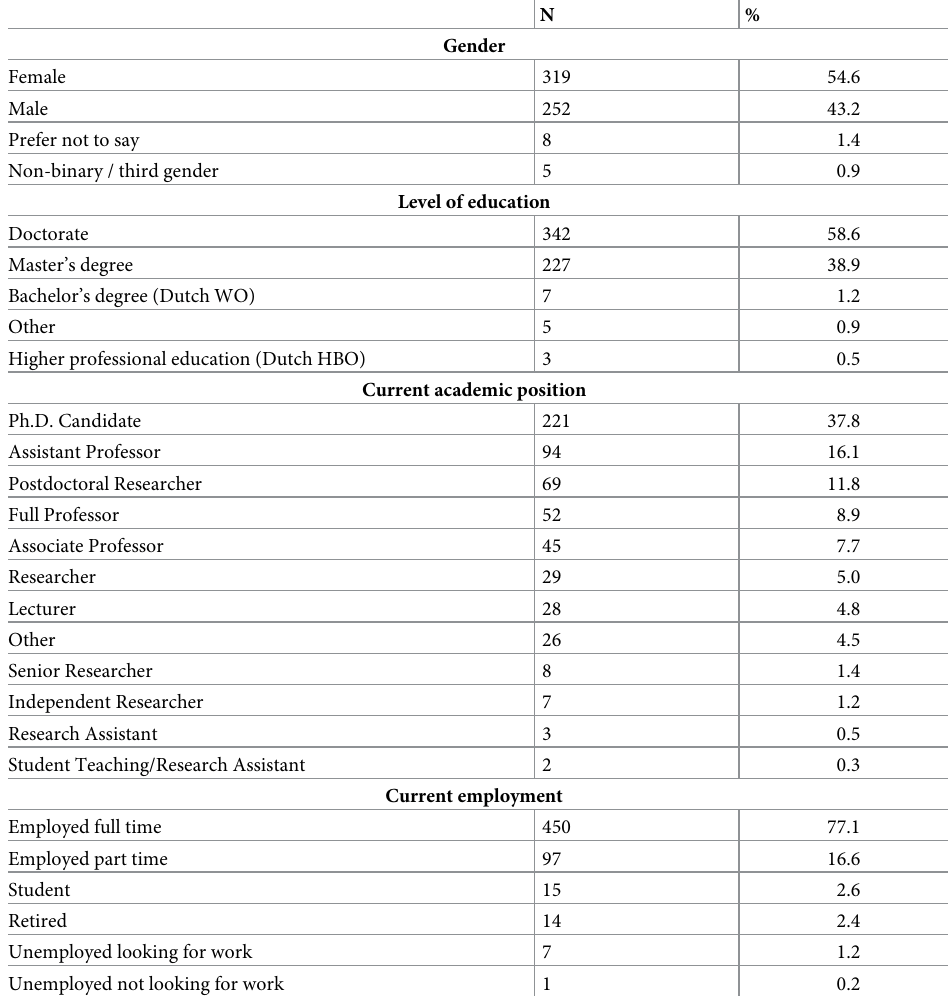
Table 7. Demographics ( N =